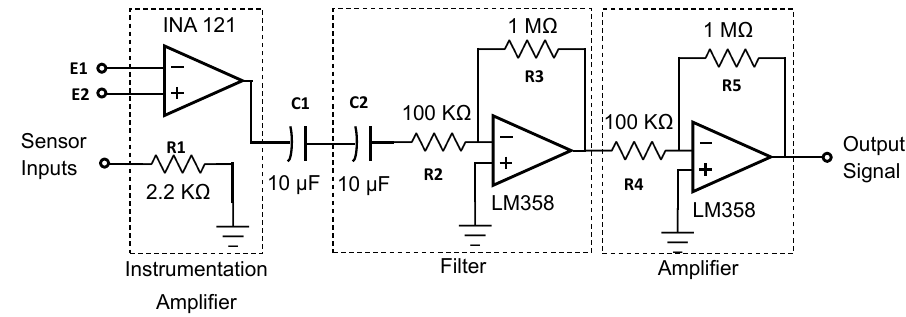
Figure 4. Schematic of our sensor processing board: the instrumentation amplifier obtains the difference of the sensor inputs, before the single signal is filtered and